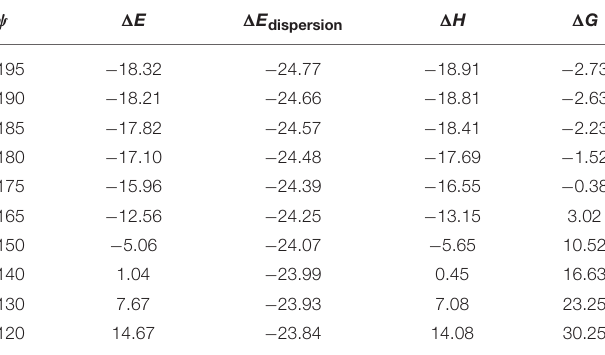
TABLE 3 | Binding energies ( 1 E) , binding enthalpies ( 1 H) , binding Gibbs free energies ( 1 G) , binding entropies ( 1 S) , relative binding Gibbs free energies ( 11 G) , and Boltzmann weights ( BW ) for the 11 selected conformers (energies in kcal/mol, entropies in J/(K • mol) and BW in %) a . Conformer